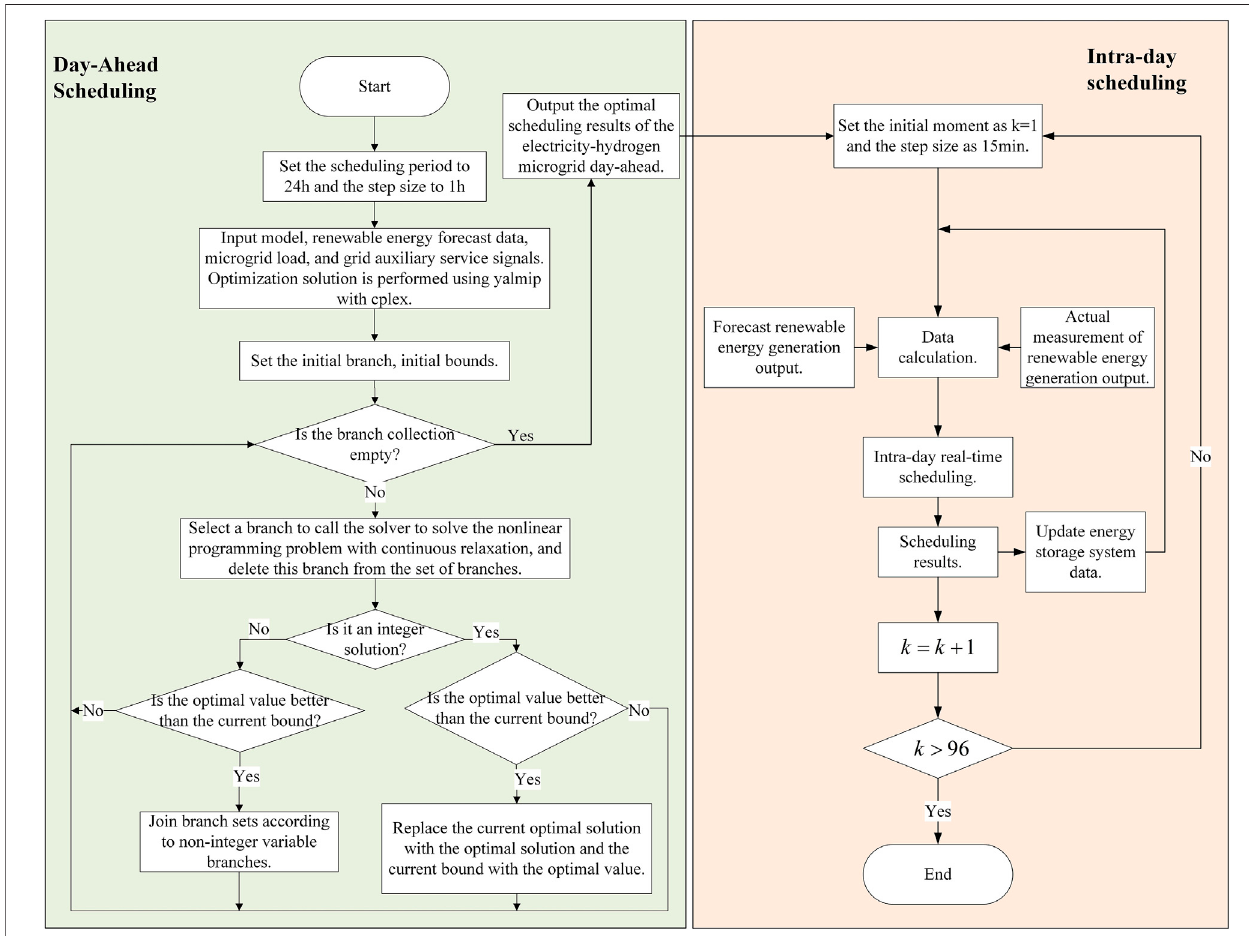
FIGURE 6 | Two-stage solution process for day-ahead and intra-day.